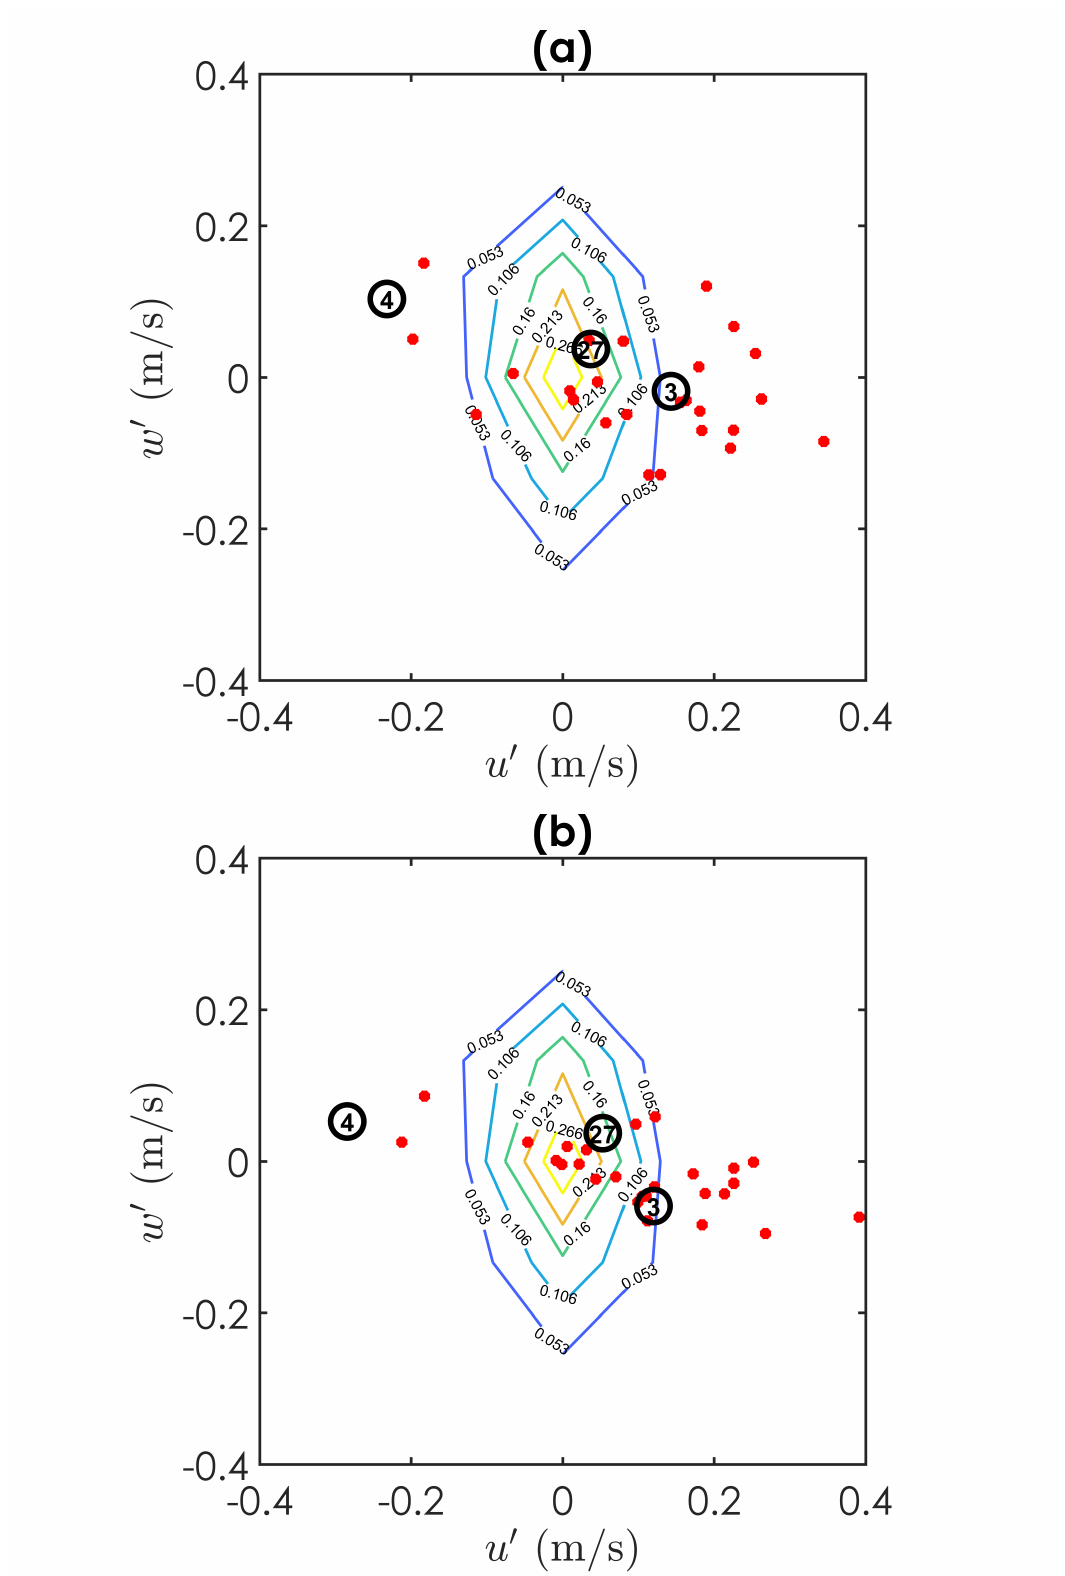
Figure 8. Reference velocity fluctuations (red dots) characterizing: ( a ) test T2-Approach A; ( b ) test T2-Approach B. Contour lines represent the 2D histogram of the velocity time fluctuations at the reference height for the entire set of PIV